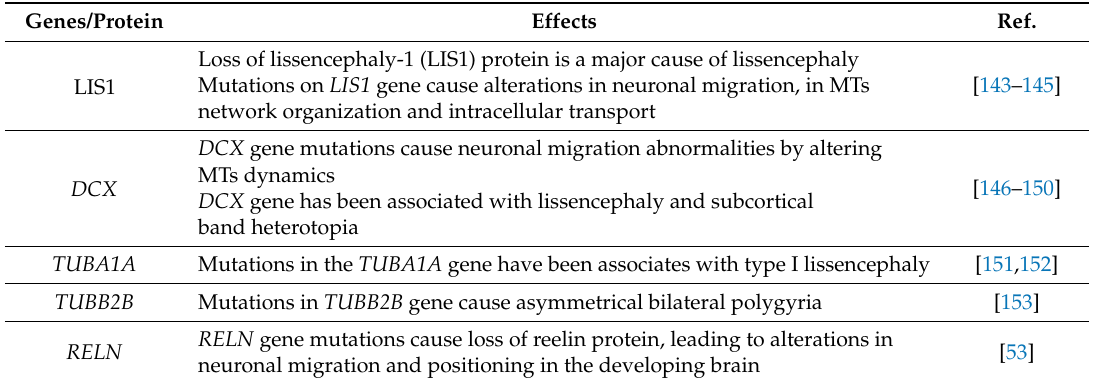
Table 3. MTs and MTs regulatory protein and gene alterations associated with